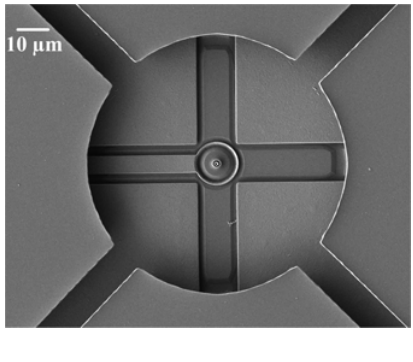
Figure 7. SEM image of the driving electrodes and pin supporter under the